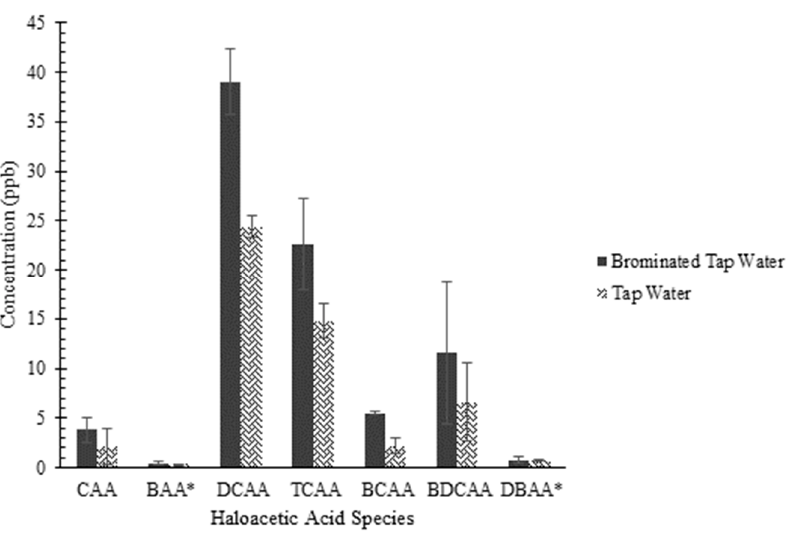
Figure 2. Concentrations of chloroacetic acid (CAA), bromoacetic acid (BAA) *, dichloroacetic acid (DCAA), trichloroacetic acid (TCAA), bromochloroacetic acid (BCAA), bromodichloroacetic acid (BDCAA), and dibromoacetic acid (DBAA) * in tap water alone (n = 3) and formed in brominated tap water (n = 18). ppb = parts per billion. * below the limit of quantification. Error bars depict standard deviation.